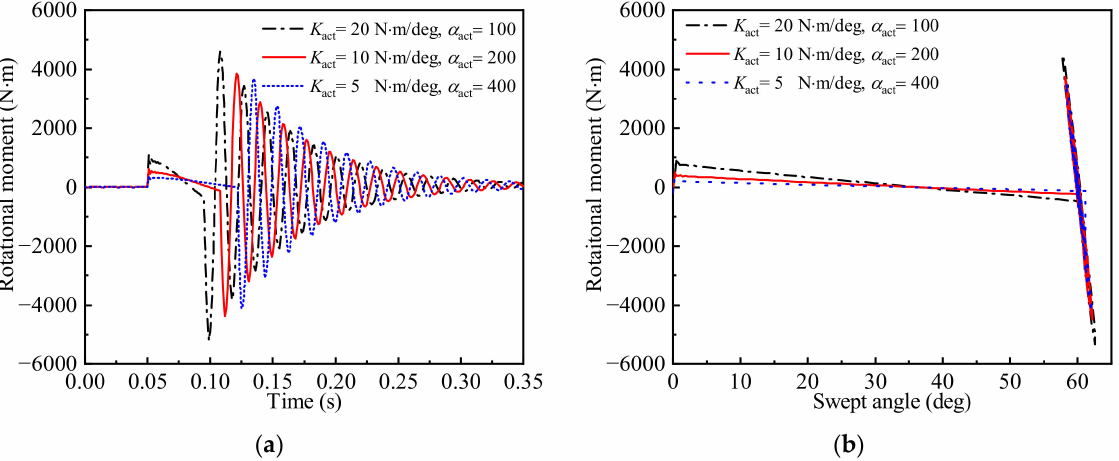
Figure 18. Transient responses of the wing root rotational moment. ( a ) Rotational moment vs. time. ( b ) Rotational moment vs. sweep angle.